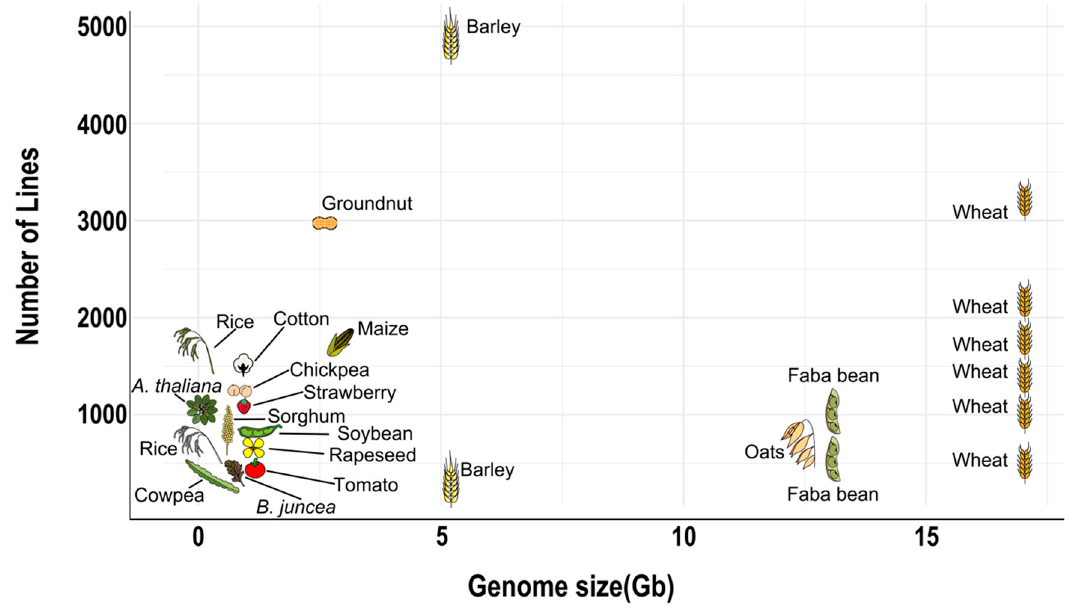
Figure 5. Population size of MAGIC populations developed compared to their genome size. Detailed information in Table 2.